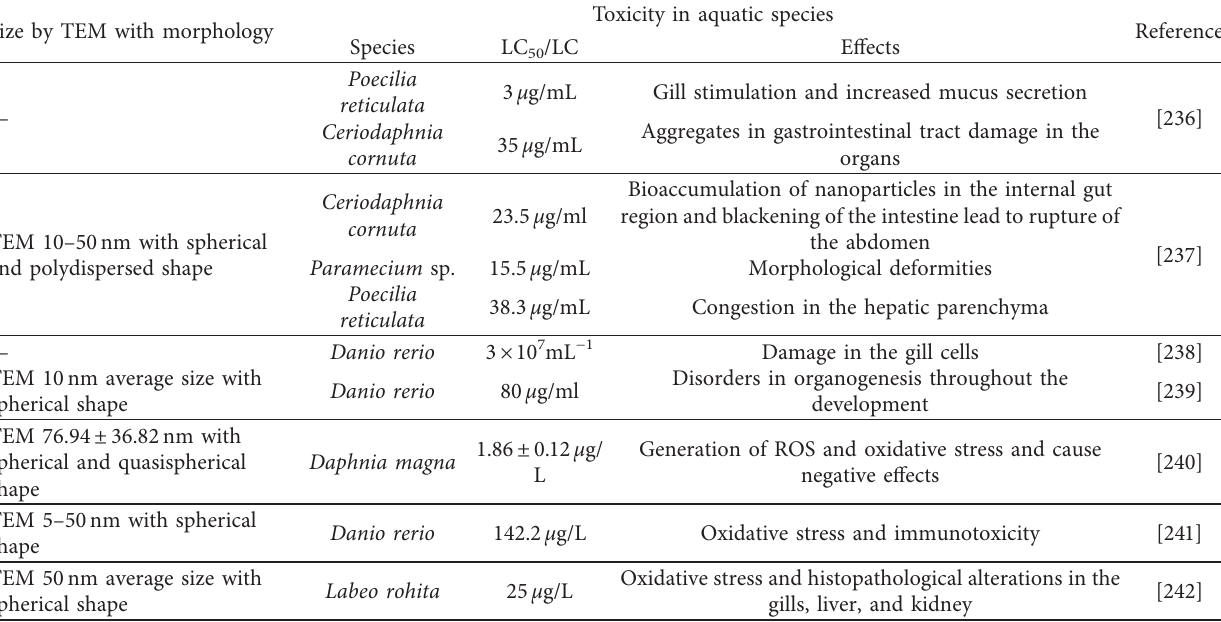
Table 11: Morphology of Ag NPs and their aquatic toxicity in different